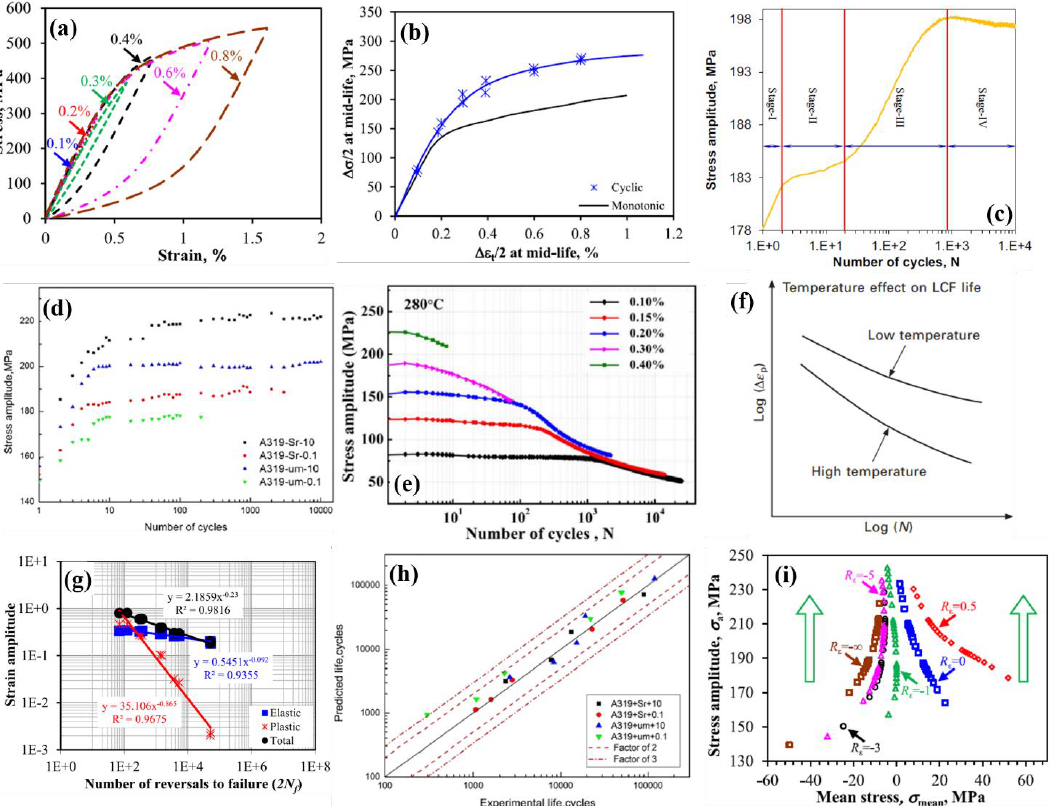
Figure 15. LCF properties including cyclic hardening/softening/stabilization. ( a ) Mid − life stress − strain hysteresis loops showing near − Masing behavior and ( b ) cyclic stress − strain curves plotted from the mid-life points in comparison with the monotonic tensile stress − strain curve to show the cyclic hardening of cast Silafont ® − 36 alloy [86]. ( c ) Four hardening stages during cyclic loading for Al − Si − Cu − Mg alloy [230]. Evolution of stress amplitude showing ( d ) cyclic hardening in cast A319 alloy [61] and ( e ) cyclic softening in Al − Si piston alloy at 280 °C [283]. ( f ) Effect of temperature on fatigue life [275]. ( g ) Basquin − Coffin − Manson equation plot for total, elastic, and plastic strain amplitudes for Silafont ® − 36 alloy at RT [86]. ( h ) Fatigue life − prediction plot for A319 alloy using a microstructure − based model [61]. ( i ) Evolution of stress amplitude in uniaxial LCF tests for cast Silafont ® − 36 alloy loaded at different strain ratios/mean stress levels [85]. Reproduced with permission from Elsevier and John Wiley and Sons.